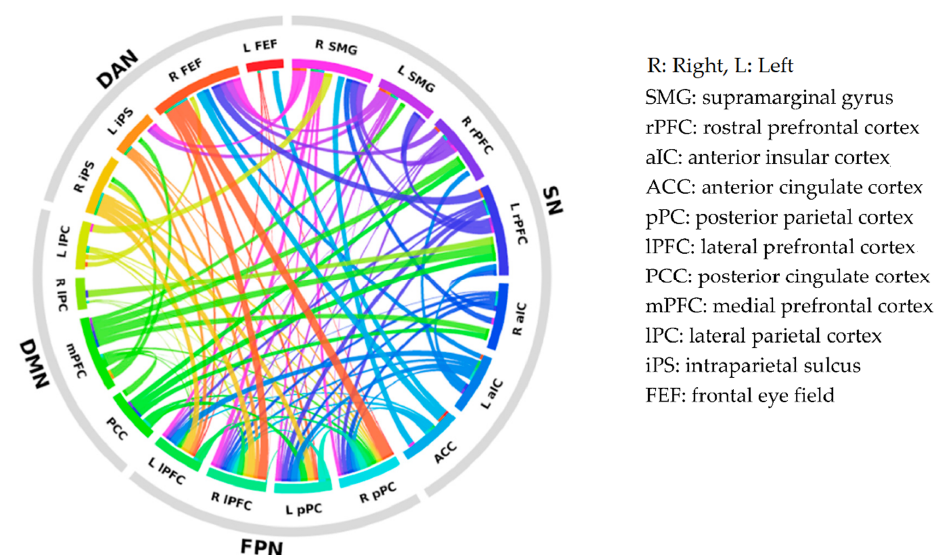
Figure 1. Connectogram of intra- and inter-network connectivity differences between subregions of the default mode network (DMN), the salience network (SN), the dorsal attention network (DAN), and the frontoparietal network (FPN). Each colored segment represents each subregion, and these are grouped according to resting-state networks. The lines connecting two segments represent the degree of connectivity strength differences between SPD and control participants. The thicker the line, the larger the strength difference. SPD: schizotypal personality disorder. J. Clin. Med. 2021 , 10 , x FOR PEER REVIEW